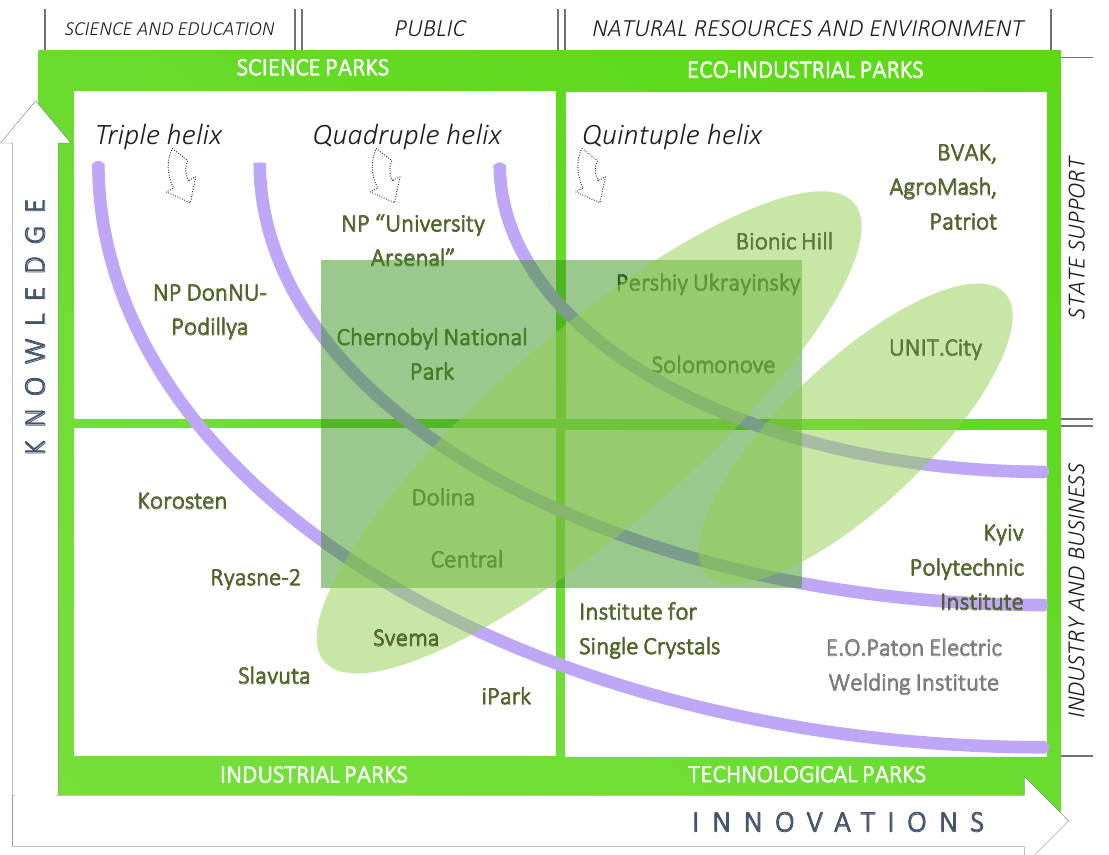
Figure 3. Quadrants of landscaping in innovation parks of Ukraine on the plane “knowledge – innovation” according to the stages of helix